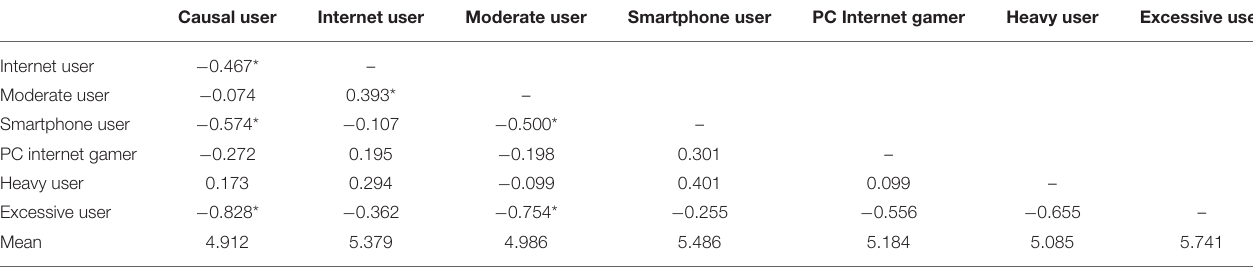
TABLE 9 | ANCOVA result comparing neuroticism among profiles (mean